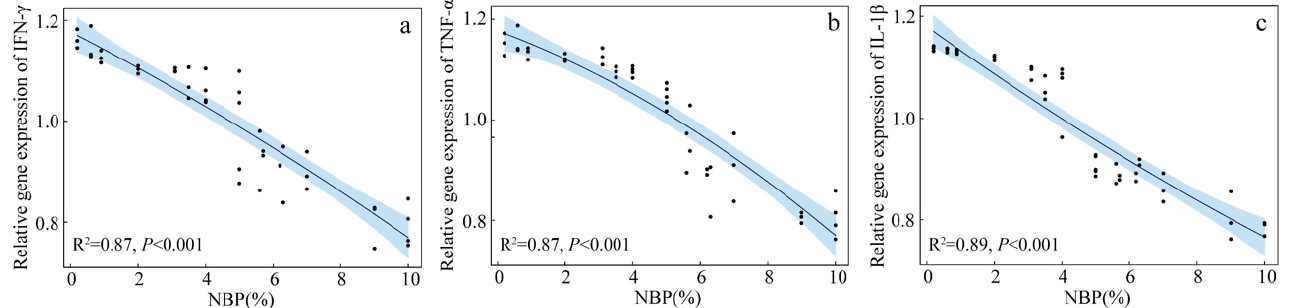
Figure 2. The relationship between grasshopper nymph biomass proportion (NBP) and the relative expression of the interferon- γ ( IFN- γ ) ( a ), tumor necrosis factor- α ( TNF- α ) ( b ), interleukin-1 β ( IL-1 β ) ( c ) genes of Asian short-toed lark ( Alaudala cheleensis ) nestlings ( n = 45). NBP is the proportion of the daily grasshopper nymph biomass relative to the total biomass measured on all survey days. The blue area is the confidence interval.